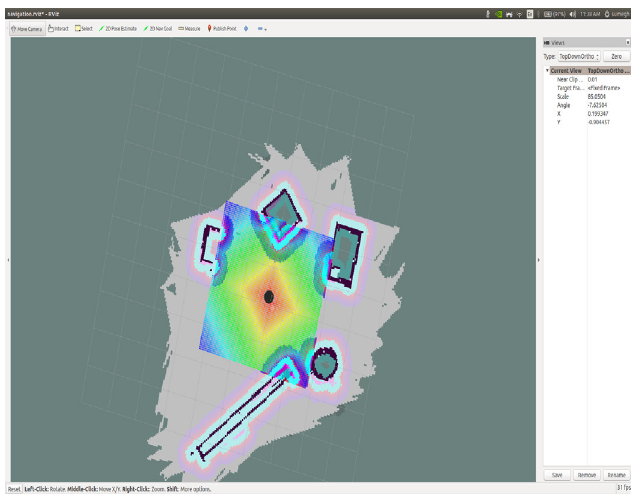
Fig. 4: Localized robot in